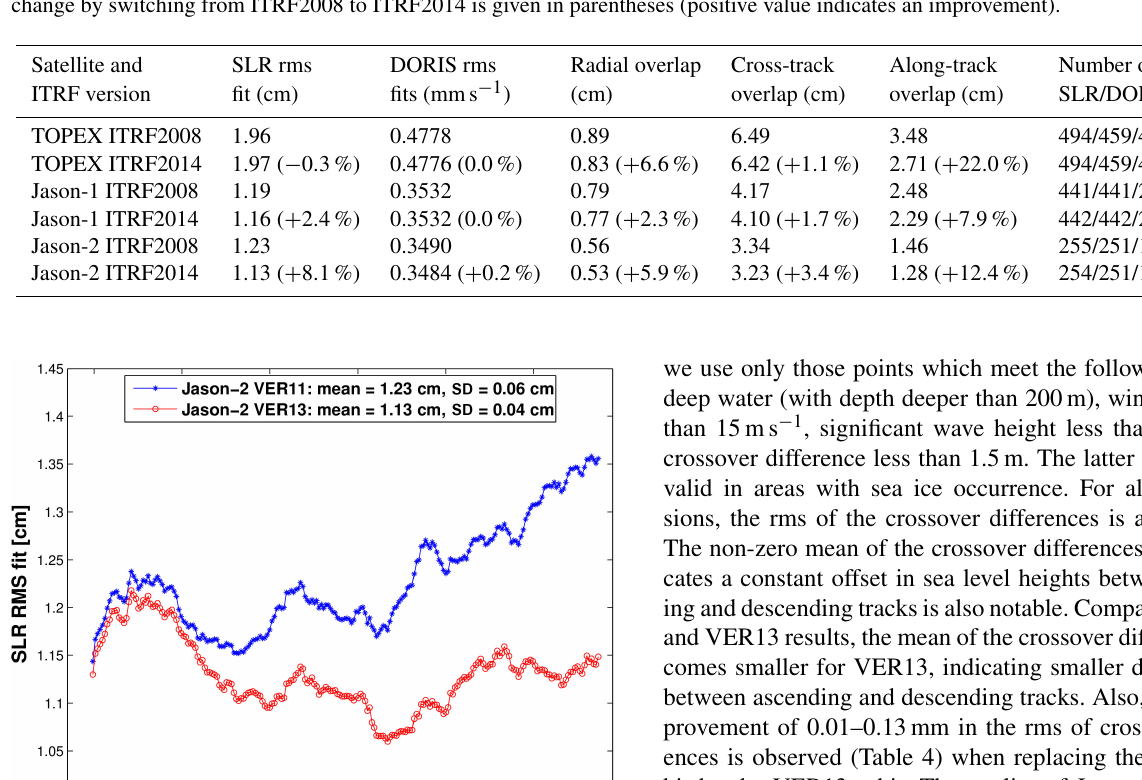
Table 3. Mean values of the rms fits of SLR and DORIS measurements, 2-day arc overlaps, and the number of arcs used to compute these values for TOPEX/Poseidon (from 23 September 1992 to 9 October 2005), Jason-1 (from 13 January 2002 to 5 July 2013), and Jason-2 (from 5 July 2008 to 6 April 2015) orbits derived at the time intervals specified using ITRF2008 and ITRF2014. The percentage of the parameter change by switching from ITRF2008 to ITRF2014 is given in parentheses (positive value indicates an improvement).